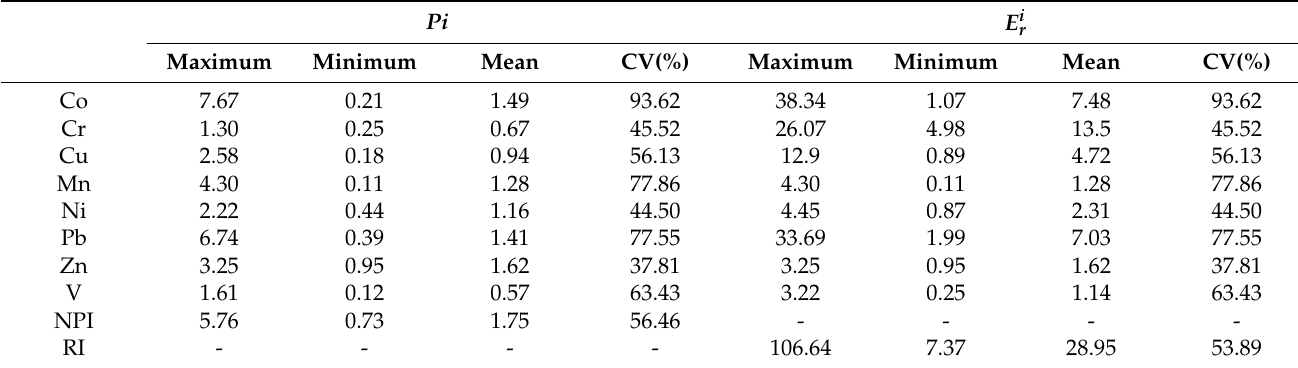
Table 2. Nemerow integrated pollution index and potential ecological risk index of potentially toxic elements in soil in the study